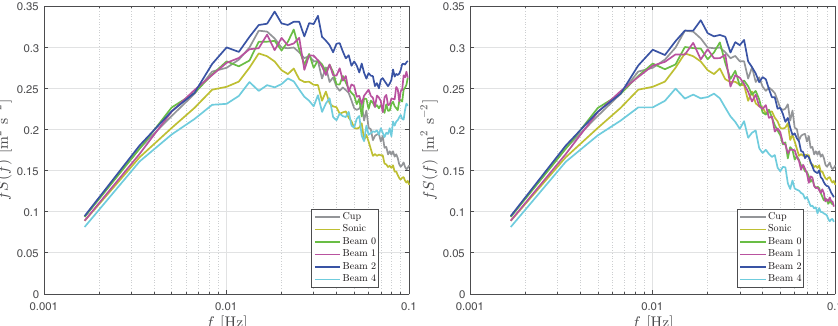
Figure 10. Ensemble-average spectrum of all 10-min Avent radial velocity spectra (per beam), sonic-anemometer u -spectrum and 80-m cup-anemometer spectrum. Original (left frame) and noise-filtered lidar radial velocity spectra (right panel)